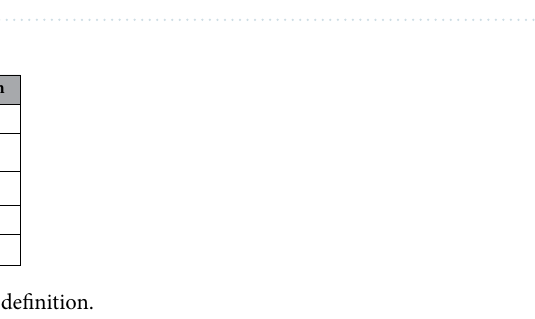
Figure 4. Comparison of the variation in average conductance ( I / V ) with bulk average concentration with Petrossian et al. 19 .